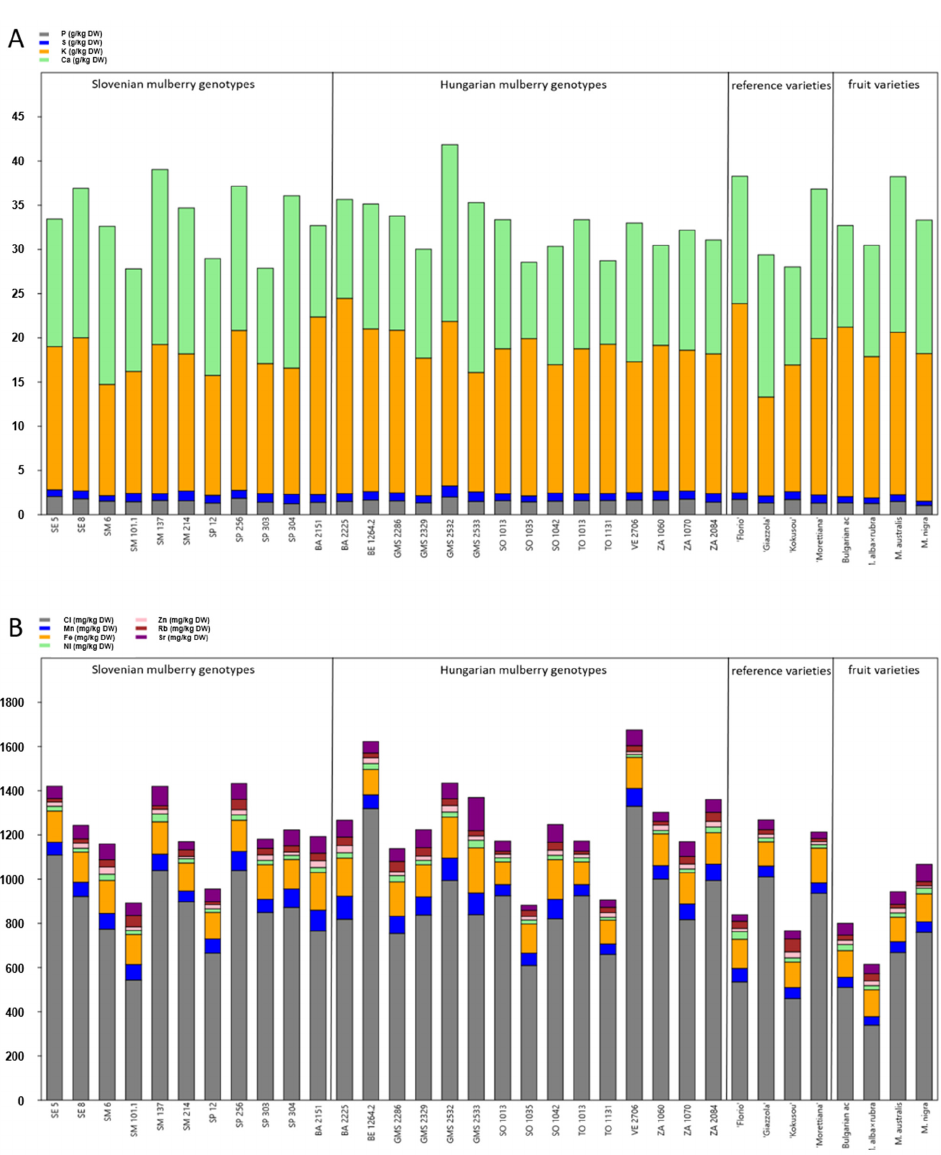
Figure 2. The mean concentrations of the ( A ) macroelements (mg/kg DW) and ( B ) microelements (mg/kg DW) in leaves of Slovenian, Hungarian old mulberry genotypes, reference sericultural and fruit varieties. For detailed data and statistics see Table 2 and Supplementary Table S3. Among microelements, maximum Cl concentrations were found in genotype BE 1264.2 (1320 mg/kg DW). Fe and Ni concentrations were the highest in genotype GMS 2533. The highest Zn concentration was found in Slovenian genotype SM 6. ‘Kokusou-20’ was found to be rich in Rb (59.4 mg/kg DW), whereas Sr concentrations ranged from 22.8